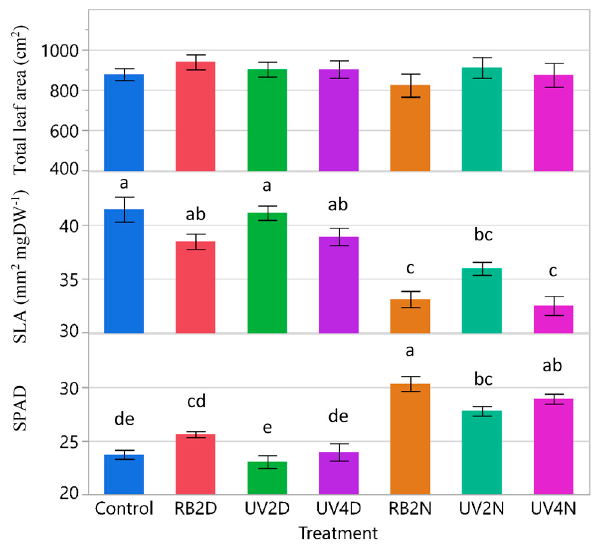
Figure 3. Total leaf area, specific leaf area (SLA), and relative chlorophyll content (SPAD), of the lettuce variety ‘Red Mist’ treated with pre-harvest supplemental UV-A/Blue (UV) or Red and Blue (RB) LED light for a duration of either two or four days (D) or nights (N), in a greenhouse hydro- ponic system (Experiment 1). The control plants did not receive any supplemental LED light. See Table 2 for treatment details. Means separated by different letters indicate significant differences according to Tukey’s HSD (honestly significant difference) test ( p < 0.05). Bars represent standard error.